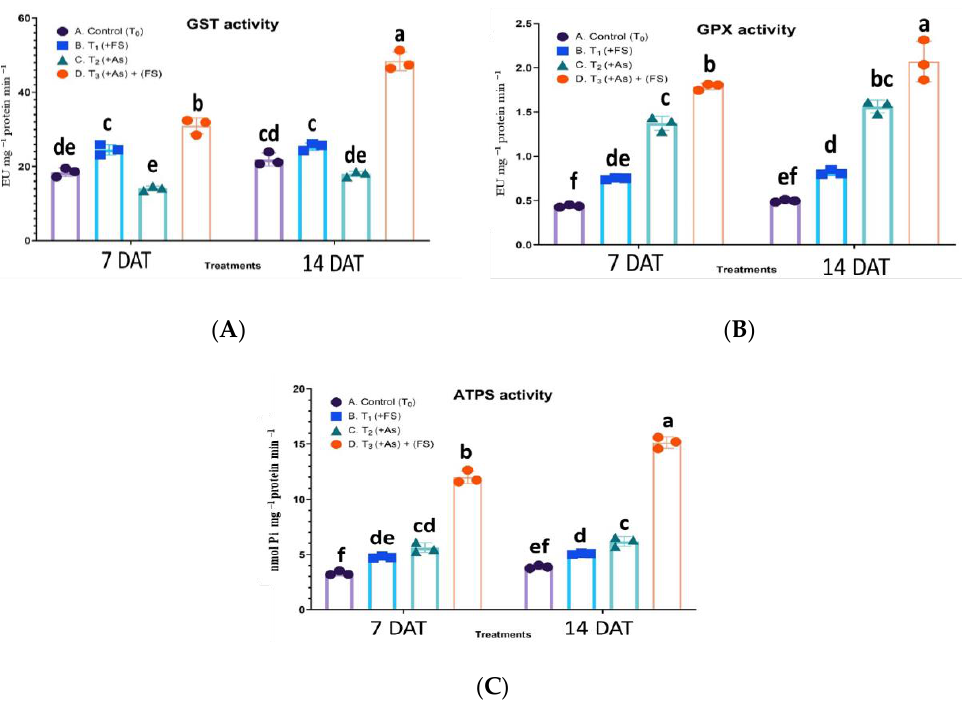
Figure 7. ( A – C ): Impact of iron sulfate (T 1 : +FeSO 4 ), arsenic stress (T 2 : +As) and iron sulfate supplementation during As stress (T 3 : As+FeSO 4 ) on the activity of Glutathione-S-transferase (GST, 7 A ), Glutathione Peroxidase (GPX, 7 B ) and ATP-Sulfurylase (ATPS, 7 C ) in the leaf of Brassica juncea studied 7 and 14 days after treatment (DAT). The values are mean ± SE and n = 3. Different letters on the bars indicate significant changes ( p < 0.05) in different treatments as determined by Tukey’s HSD test. As, Arsenic; FS, FeSO 4 .